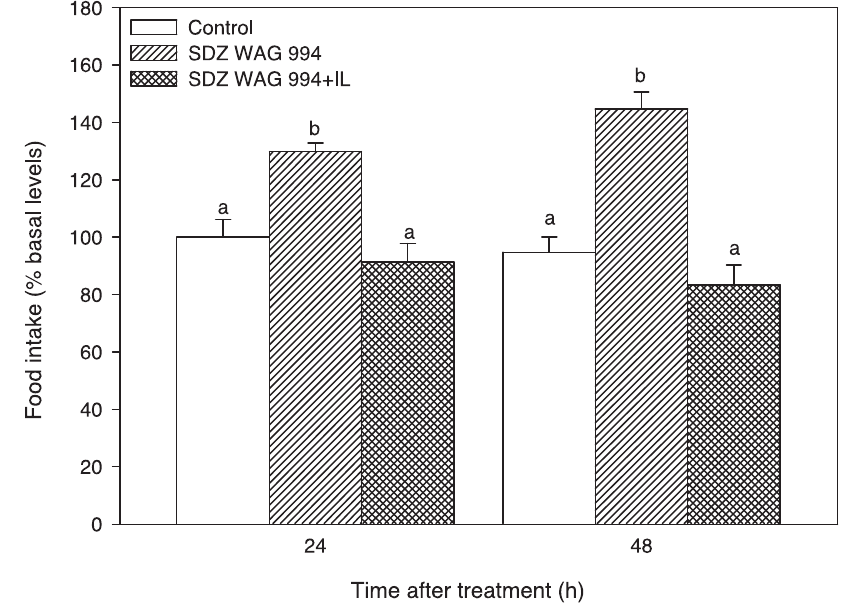
Figure 1. Changes in food intake after intraperitoneal treatment. Food intake of rainbow trout after 6 h or 24 h of intraperitoneal administration of 10 mL.Kg 2 1 of saline solution alone (control) or containing SDZ WAG 994 alone (60 m g.Kg 2 1 ) or containing SDZ WAG 994 (60 m g.Kg 2 1 ) together with intralipid (3 mL.Kg 2 1 ) solution. Different letters indicate significant differences ( P , 0.05) among treatments at the same time. Food intake is shown as mean + S.E.M. of the percentage of food ingested with respect to basal levels (calculated as the average of food intake the three days previous to experiment). The results are shown as mean + S.E.M. of the results obtained in three different tanks in which 8 fish were used per group in each tank. Different letters indicate significant differences ( P , 0.05) among treatments at each time.